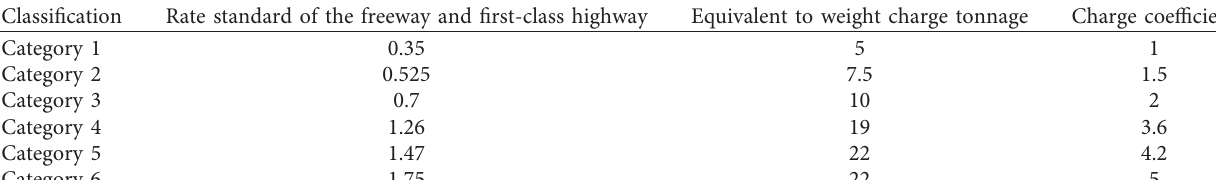
Table 8: Calculation fee coefficient and rate standard of freeway goods vehicle model mapping.